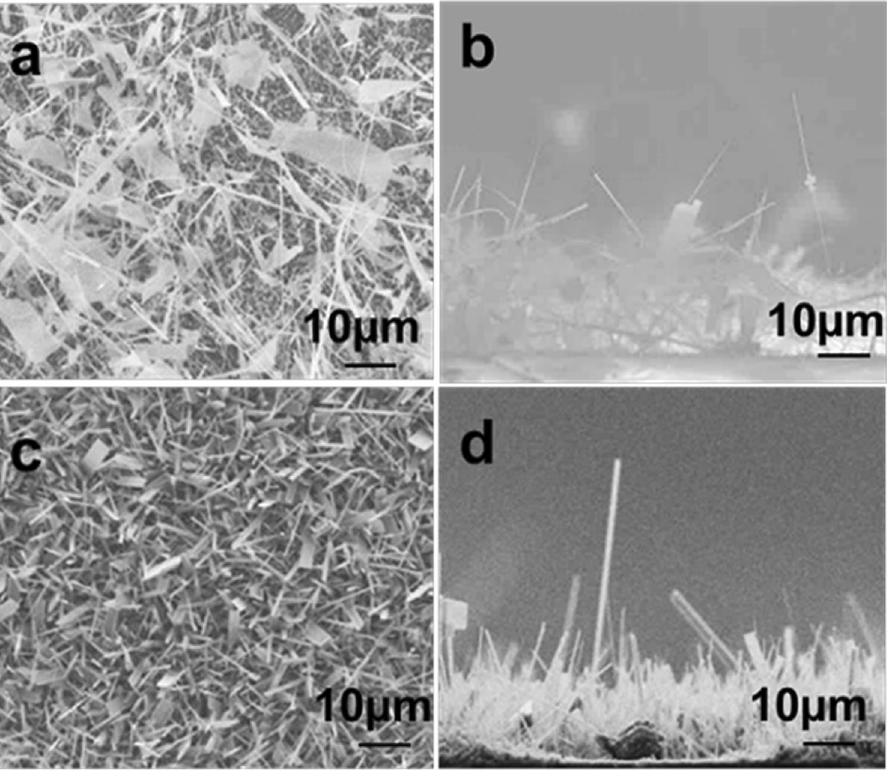
Figure 2. Ga 2 O 3 nanowire grown at 1000 °C. ( a , b ) Top and side views of Ga 2 O 3 on a quartz substrate, respectively. ( c , d ) Top and side views of Ga 2 O 3 on quartz catalyzed by 5 nm Ag, respectively. Longer and denser NWs were achieved when Ag films are present on the sample before growth.